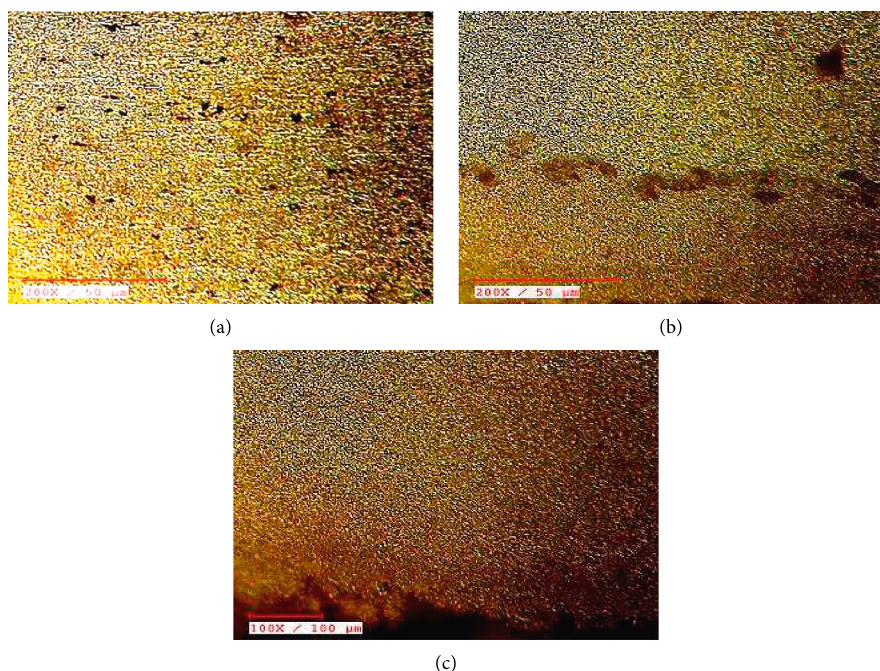
Figure 4: Microstructure of the (a) base metal, (b) shoulder zone with 0 ° tool angle, and (c) shoulder zone with 1.5 ° tool